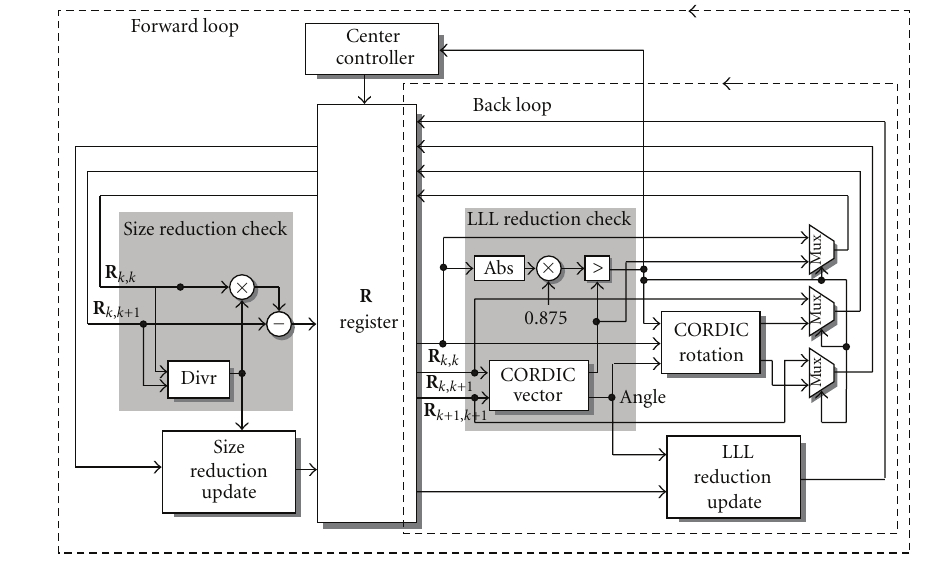
Figure 4: Hardware architecture for LR-LLL algorithm. Table 6: FPGA implementation results and comparison.